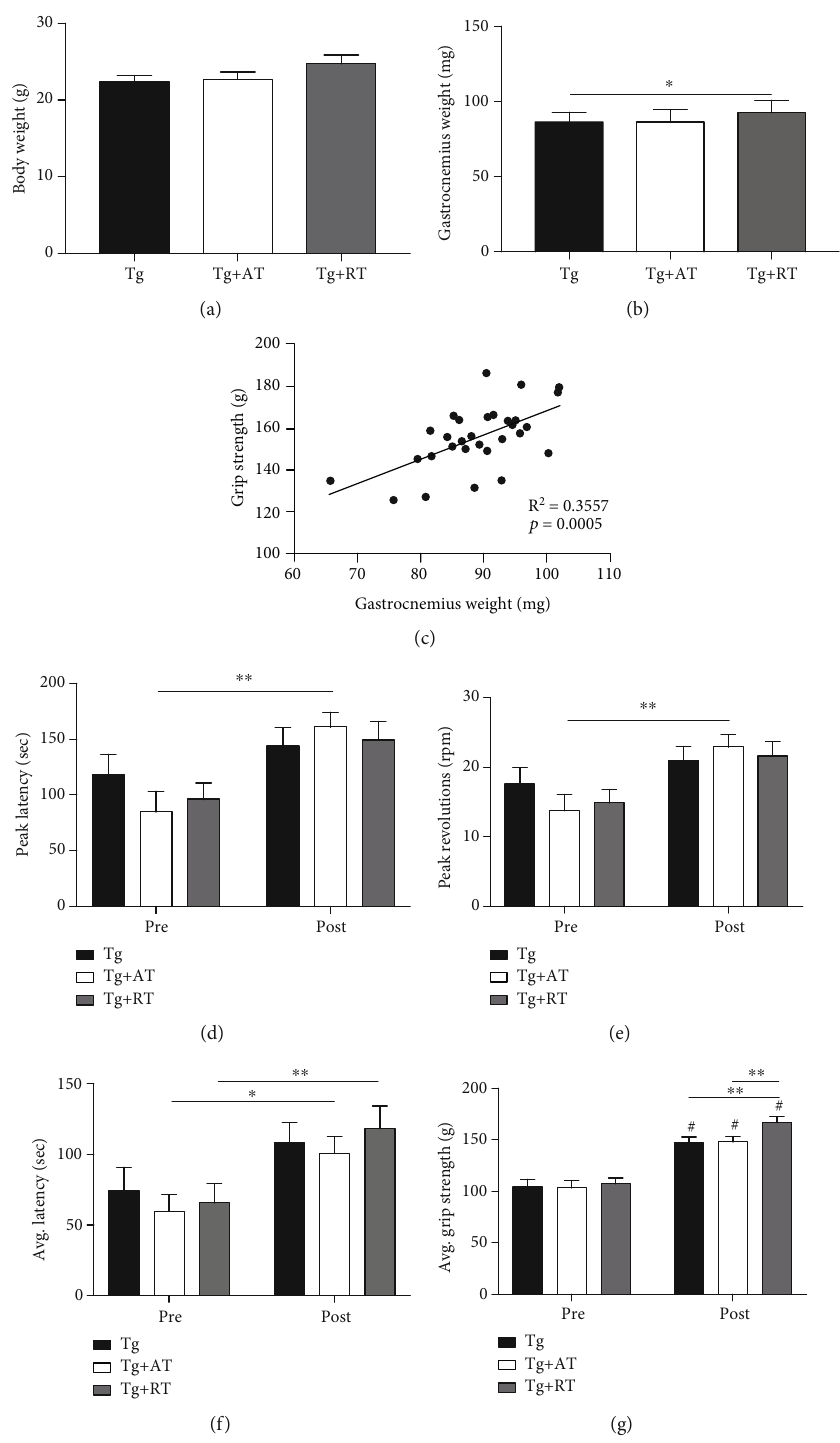
Figure 1: Phenotype of aerobic- and resistance-trained 3xTg-AD mice. Three-month-old 3xTg-AD mice were assigned to one of the following groups: nonexercised (Tg), aerobic trained (Tg+AT), or resistance trained (Tg+RT) ( n = 10 /group). Training was performed for 9 weeks, followed by tissue collection. Physical function was evaluated longitudinally, at pre- and posttraining. (a) Final body weight measured at the end of the experiment. (b) Wet weight of the gastrocnemius. (c) Association of gastrocnemius weight with grip strength. (d) Peak latency (time to fall in seconds) on the rotarod test. (e) Peak revolutions per minute (RPM) achieved on the rotarod test. (f) Average latency (time to fall in seconds) averaged across four trials on the rotarod. (g) Average forelimb grip strength across four trials. Data presented as mean ± SE . Di ff erences determined by one-way ANOVA. ∗ p < 0 : 05 and ∗∗ p < 0 : 01